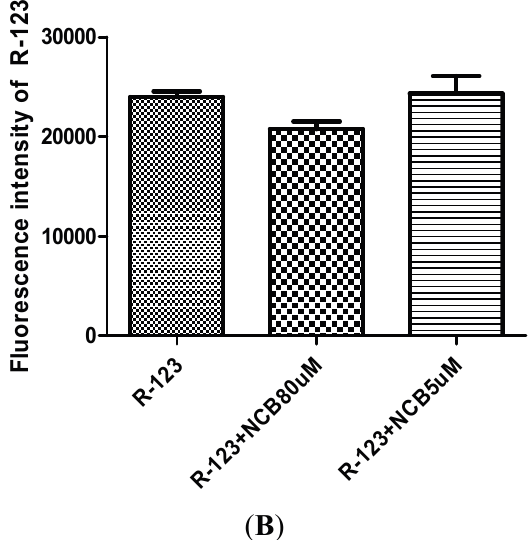
Figure 3. R-123 accumulation assays in MDCK and MDCK-hMDR1 Cells. For co-incubation with different concentrations of NCB and verapamil, the